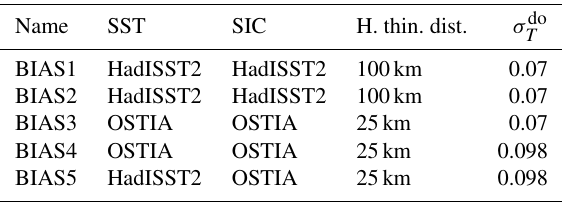
Table 4. Summary of ORAS5 offline bias correction ensemble esti-